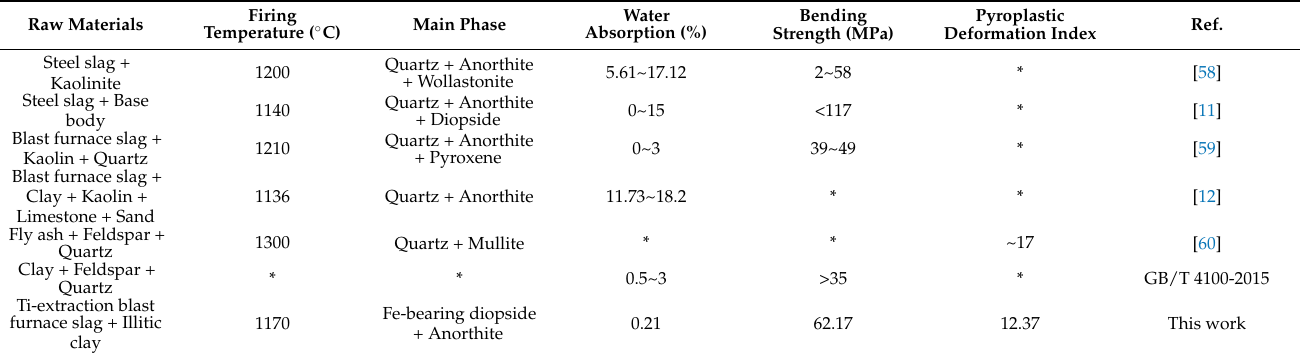
Table 6. Comparison of this work with ceramic samples derived from other studies and